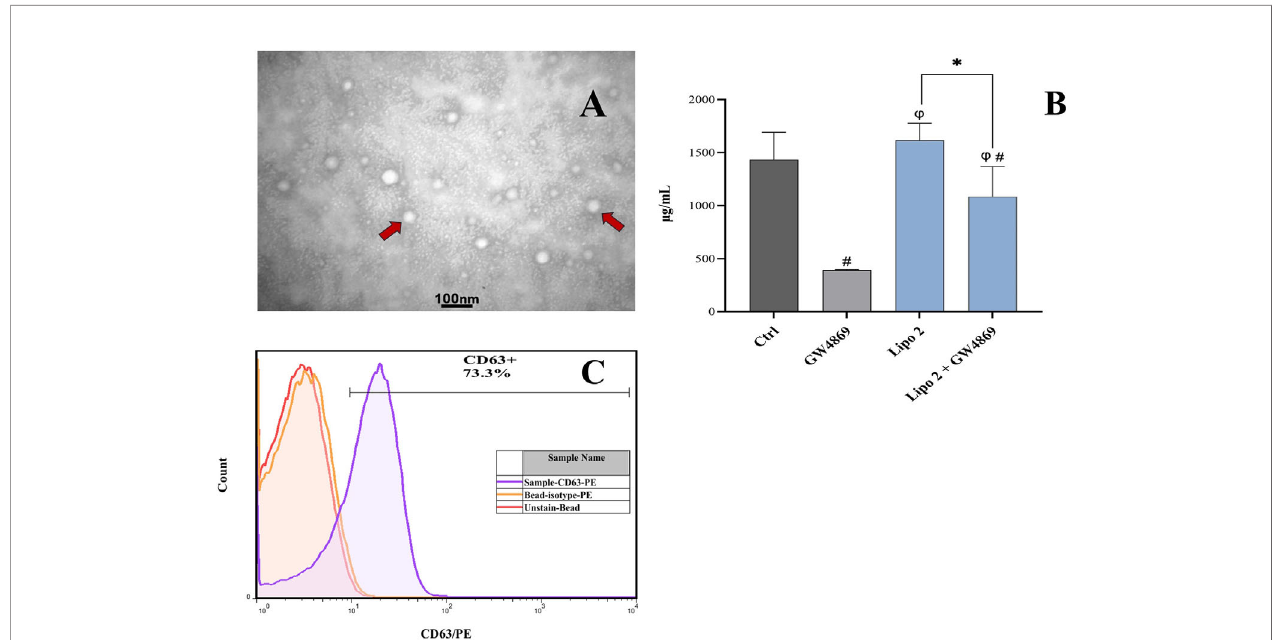
FIGURE 3 | Characterization of exosomes isolated from U937 cells. (A) TEM micrograph shows cup-shaped morphology, (B) BCA protein concentration assay reveals decreased protein concentration after GW4869 treatment, # Signi fi cantly different compared to the control (P < 0.05), *Signi fi cantly different compared to the same concentration with/without GW4869 (P < 0.05), j Signi fi cantly different compared to the GW4869-treated group, (C) The isolated U937 exosomes are positive for the CD63 marker.